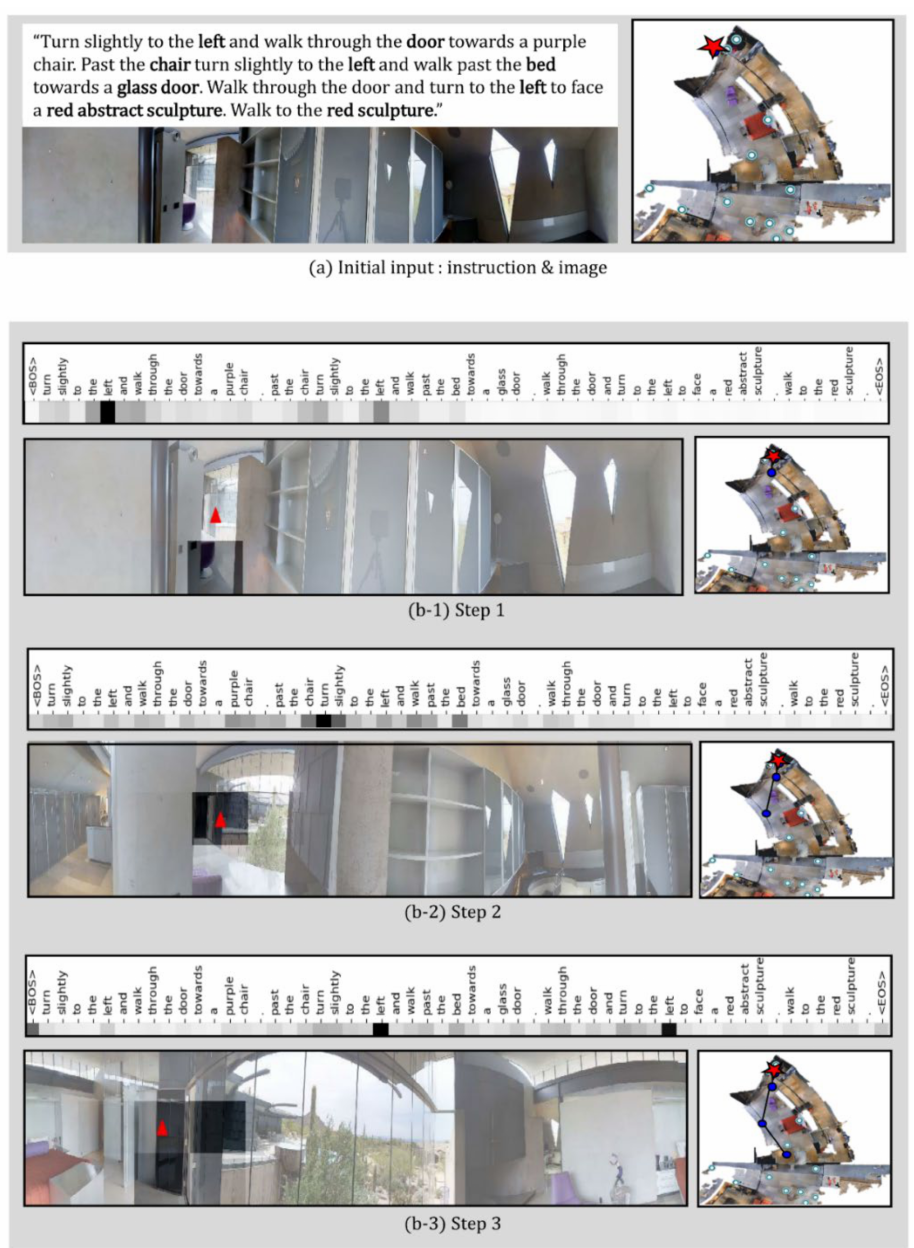
Figure 10. First example of VLN task executed by the proposed model JMEBS: